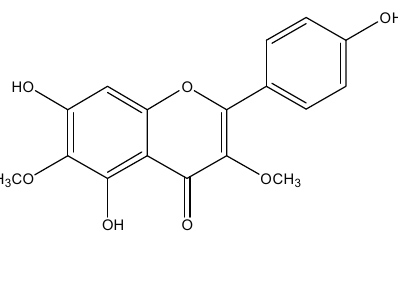
Figure 1. Chemical structure of galetin 3,6-dimethyl ether